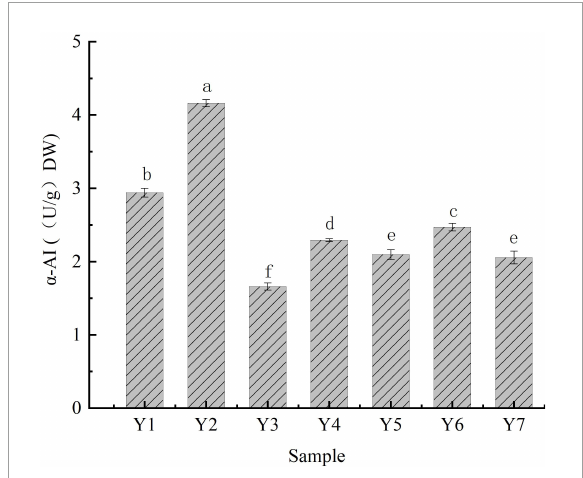
FIGURE2 α -AI-specific activities of kidney beans. Bars with different letters indicate significant differences ( p < 0.05).